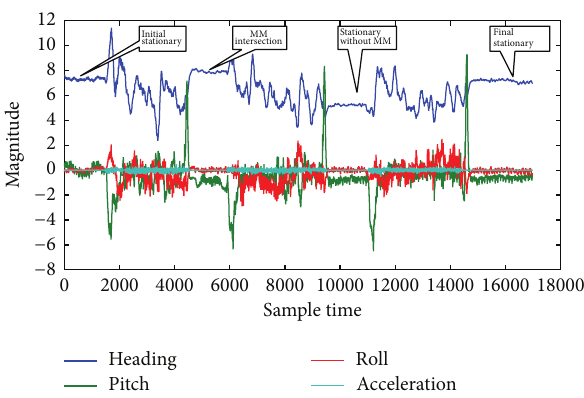
Figure 15: Stationary detection from acceleration, heading, and pitch and roll signal in the second